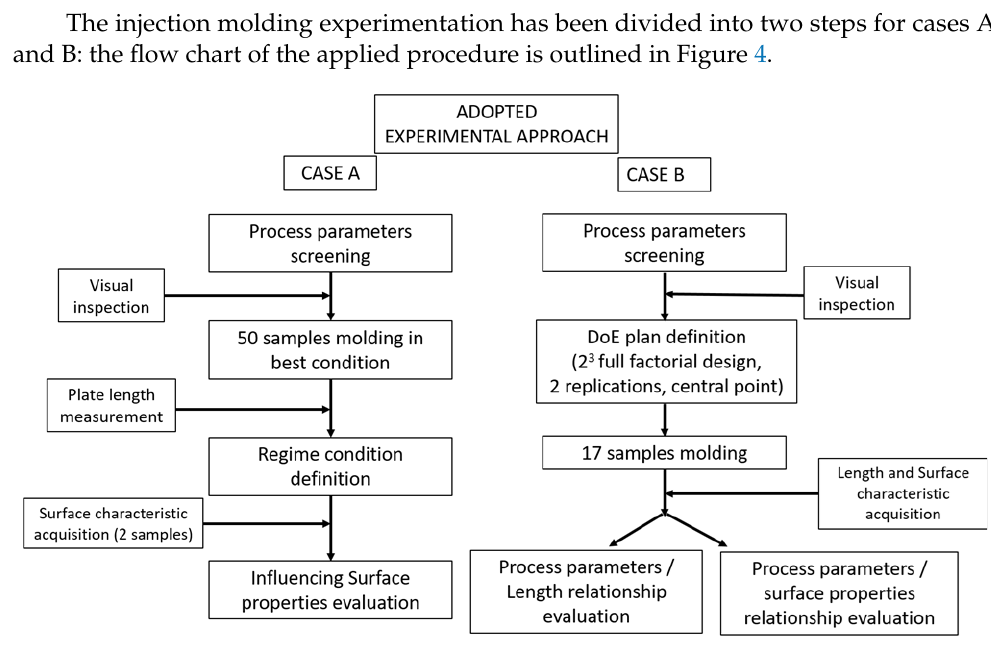
Figure 4. Adopted experimental approach.